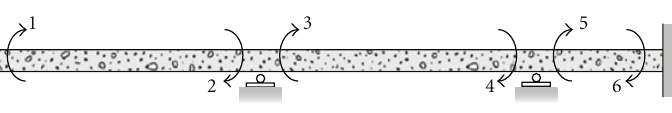
Figure 13: Reference coordinates for the fourth example.